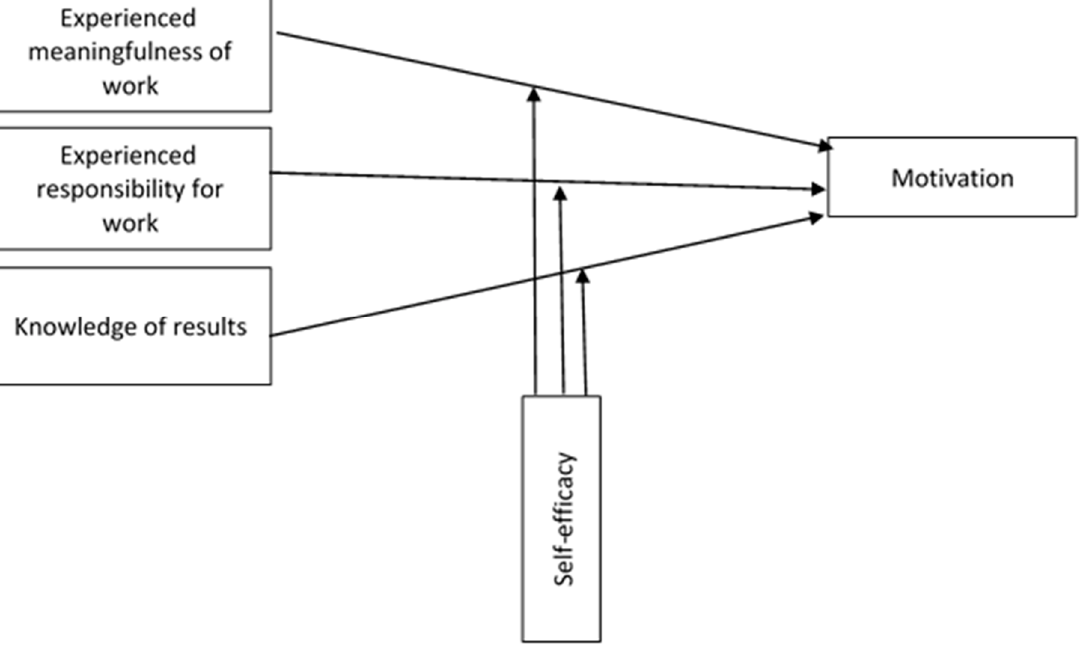
Figure 1. Conceptual model and hypotheses of impact of the three internal psychological states on motivation: the moderating effect of self-efficacy.